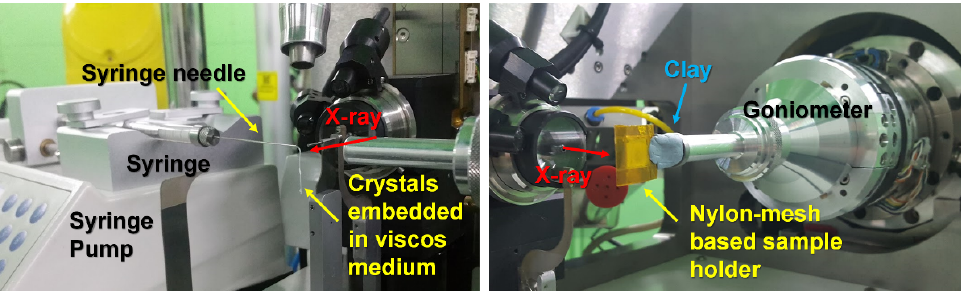
Figure 1. Photo of the experimental setup of serial synchrotron crystallography (SSX). ( left ) Delivery of crystals embedding viscous medium via a syringe and syringe pump [21] . ( right ) Fixed-target scanning using nylon-mesh and enclosing film (NAM) holder [22] .